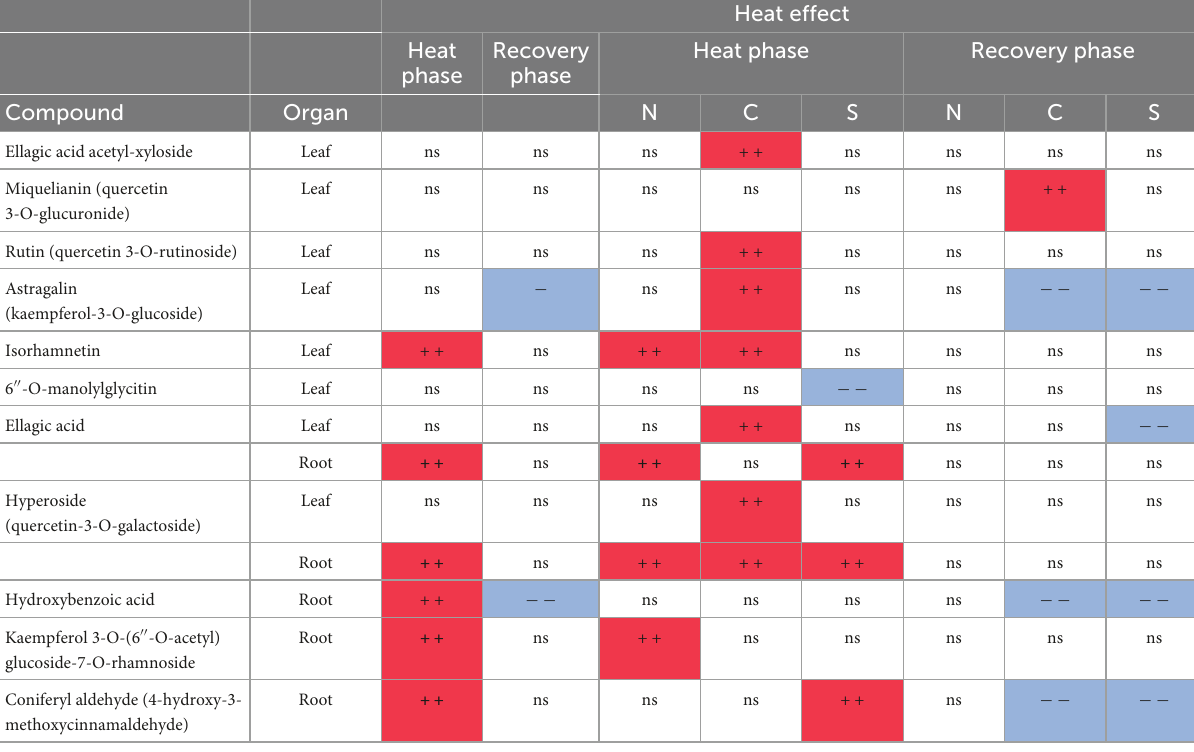
TABLE 4 Significant changes in leaves and roots of secondary metabolite-derived compounds of 6-month-old Castanea sativa seedlings from three populations (N-Northern; C-Central; S-Southern; n = 6 per population in heat phase; n = 4 per population in recovery phase) subjected to heat stress for 7 days ( n = 18; heat phase) and 10 days after application ( n = 12; recovery